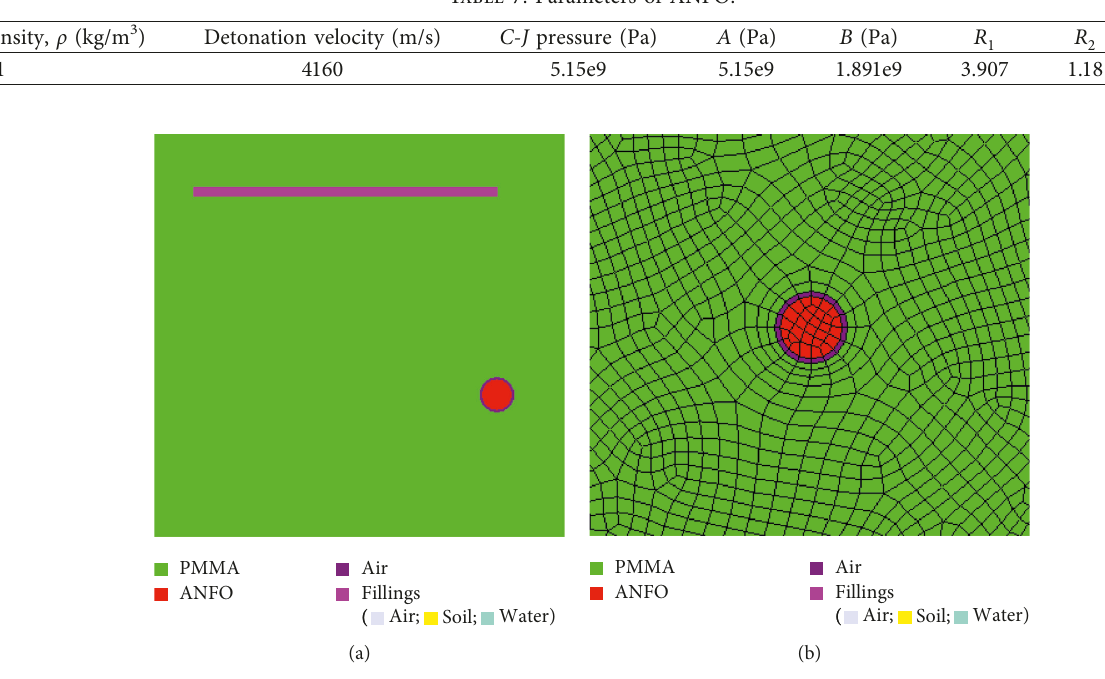
Figure 9: (a) Material location; (b) gird